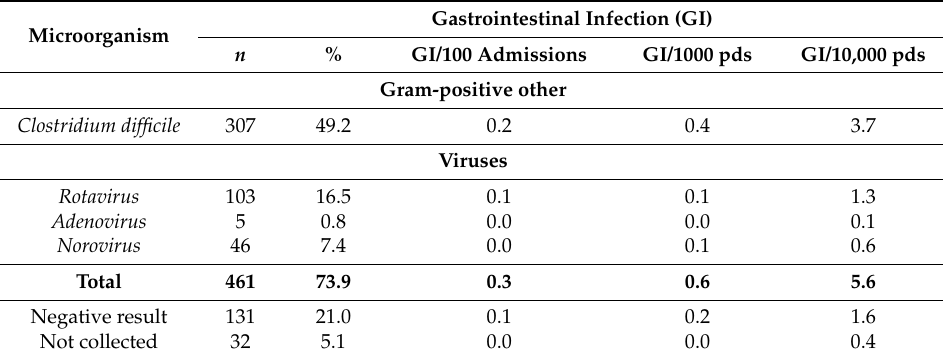
Table 5. Incidence of gastrointestinal infections according to